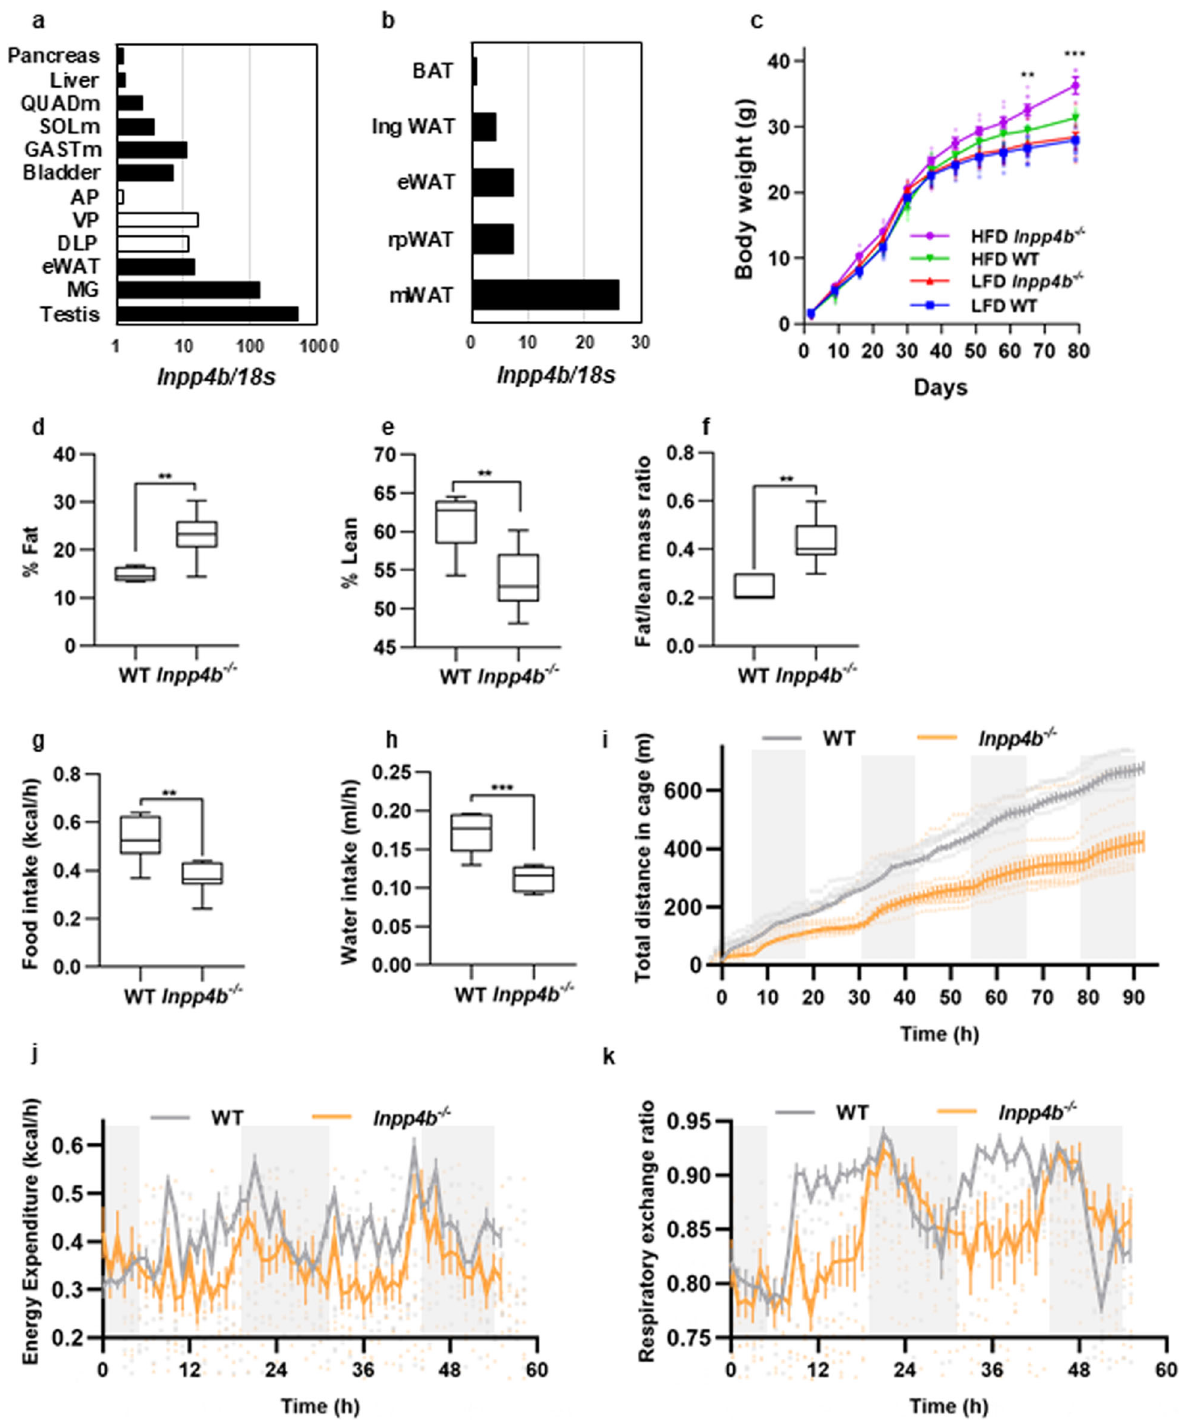
Fig. 1 Inpp4b − / − males accumulate more fat due to decreased activity, energy expenditure, and respiratory exchange ratio. a Expression of Inpp4b in mouse tissues. b Expression of Inpp4b in epididymal, retroperitoneal, mesenteric, inguinal, and brown adipose tissue of FVB males. c Body weights of LFD WT ( N = 14), LFD Inpp4b − / − ( N = 12), HFD WT ( N = 9), and HFD Inpp4b − / − ( N = 10) mice were recorded every week beginning on post-partum day 2. LFD WT, LFD Inpp4b − / − , HFD WT, and HFD Inpp4b − / − groups are represented by the blue line with squares, red line with up-pointing triangles, green line with down-pointing triangles, and purple line with circles, respectively ( ** p = 0.0048, *** p = 0.001). d – f Percent fat ( ** p = 0.0012) ( d ), and percent lean ( ** p = 0.0014) ( e ) were determined by NMR and the ratios of fat-to-lean mass ( ** p = 0.00015) ( f ) were calculated for WT ( N = 6) or Inpp4b − / − ( N = 10) mice. g , h Hourly food ( ** p = 0.0027) and water intake ( *** p = 0.00023) were recorded for the WT ( N = 6) or Inpp4b − / − ( N = 8) mice. i Mouse ambulatory activity was detected with XYZ beam array over 92 h in WT ( N = 6) or Inpp4b − / − ( N = 10) mice. Total distances were acquired by MetaScreen and processed using ExpeData. j , k Animals were acclimated in cages for the fi rst 42 h. Time course of energy expenditure ( j ) and respiratory exchange ratio ( k ) over subsequent 55 h in WT ( N = 6) or Inpp4b − / − ( N = 8) male mice using CLAMS analysis.